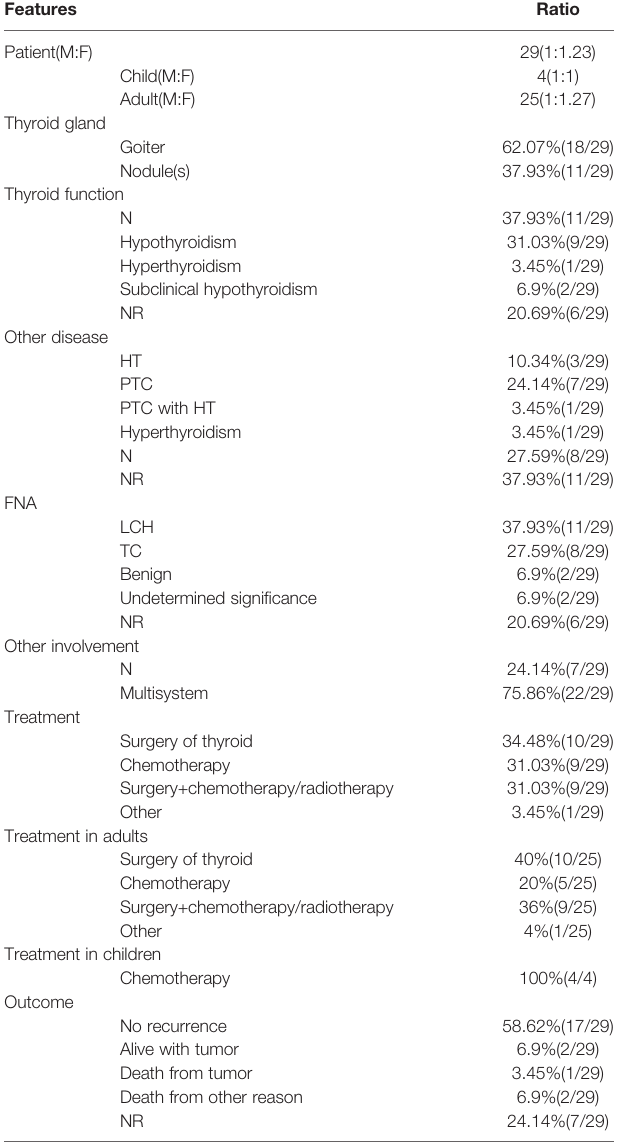
TABLE 2 | The demography, clinicopathologic features, diagnose, treatment and outcome of patients with thyroid LCH involvement.